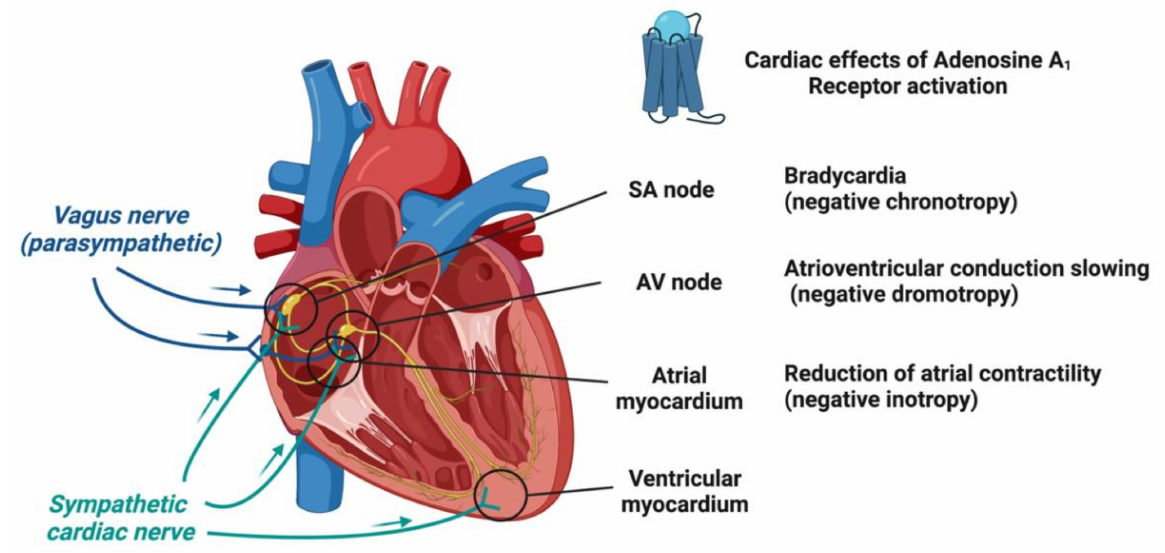
Figure 2. Cardioprotective effects of adenosine A 1 receptors’ activation. Stimulation of the A 1 receptors induces bradycardia (negative chronotropy) on a sinoatrial node (SA node), atrioventricular conduction slowing (negative dromotropy) on an atrioventricular node (AV node) and reduced atrial cardiomyocyte contractility (negative